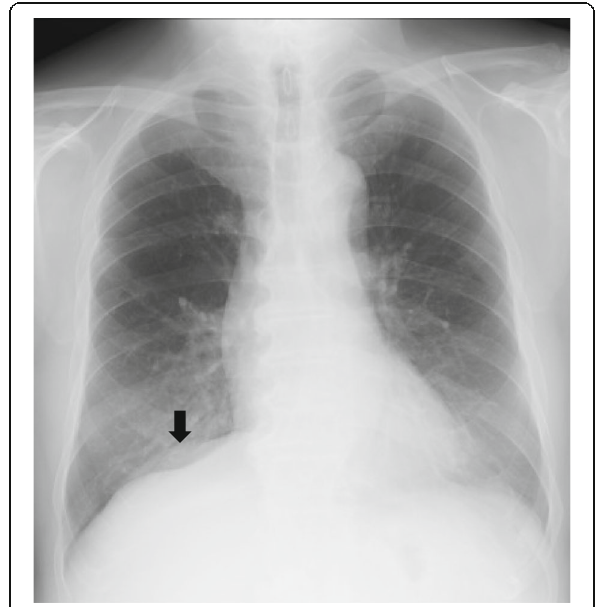
Fig. 1 A chest X-ray film showing a double line on the right diaphragm (arrow)